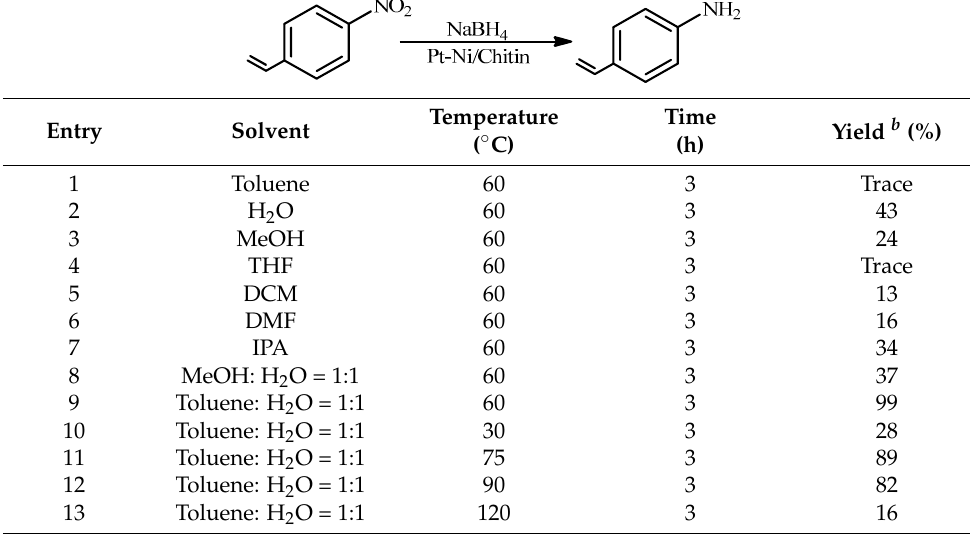
Table 2. Effect of solvent and temperature on the hydrogenation of 4-nitrostyrene a .